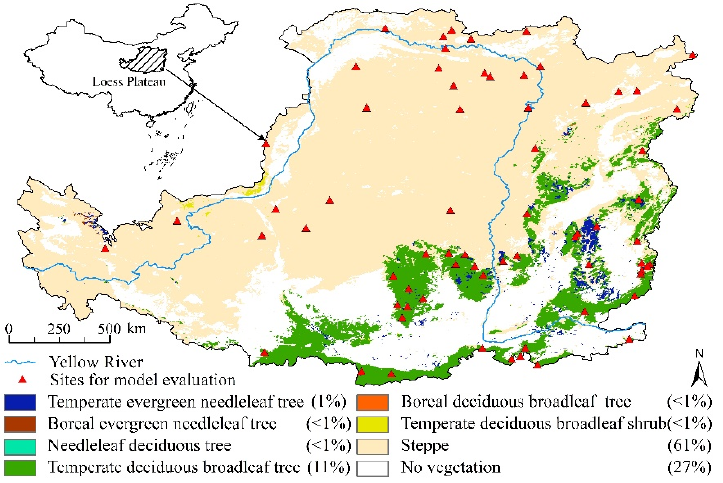
Figure 1. Location of current typical vegetation types and the sites used for model evaluation of the Loess Plateau